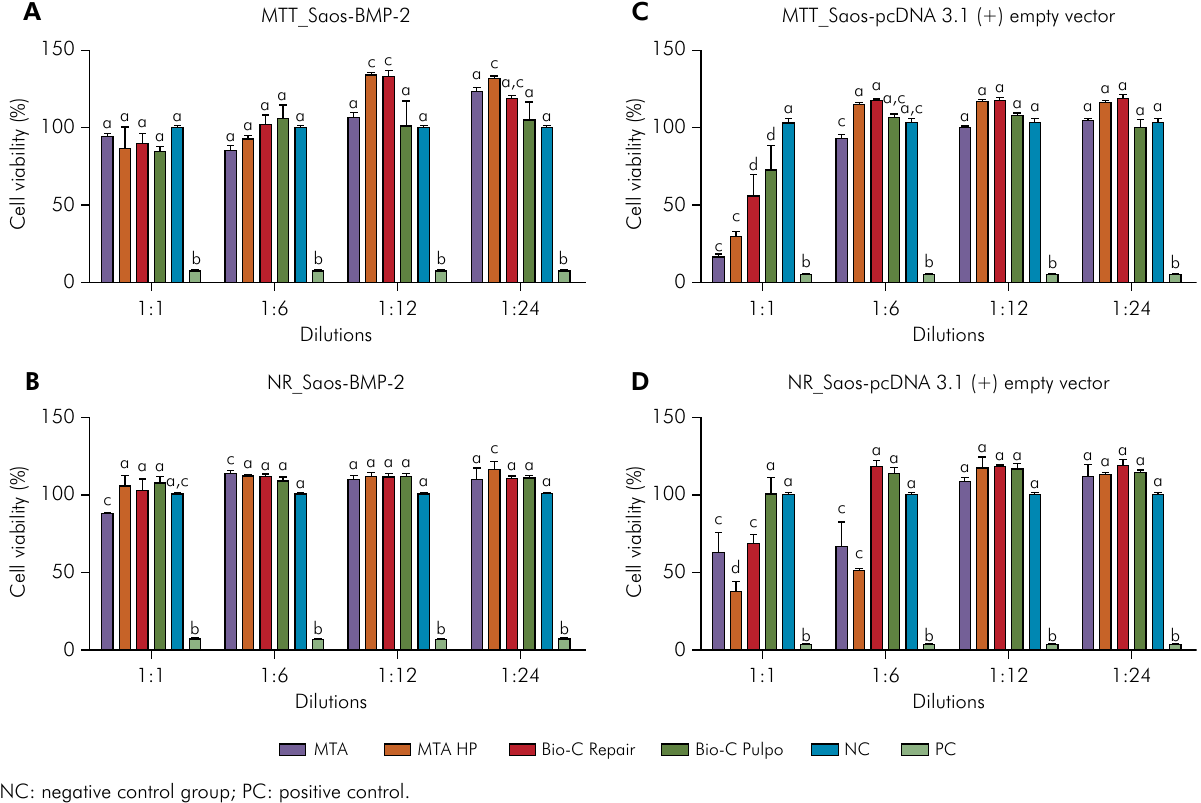
Figure 1. Cell viability rate (%) according to MTT and neutral red (NR) assays in Saos-2 osteoblastic-transfected cells: (a and b) Saos-BMP-2 and (c and d) Saos-pcDNA 3.1 (+) empty vector, exposed to MTA, MTA HP, Bio-C Repair, Bio-C Pulpo and serum-free culture medium used as a control in different dilutions (1:1, 1:6, 1:12 and 1:24) for 24 h. Three independent experiments were performed in sextuplicate for each experimental group and outcome (n = 3/group). Bars with different letters represent a significant difference among the groups in each dilution. ANOVA, Bonferroni (p <